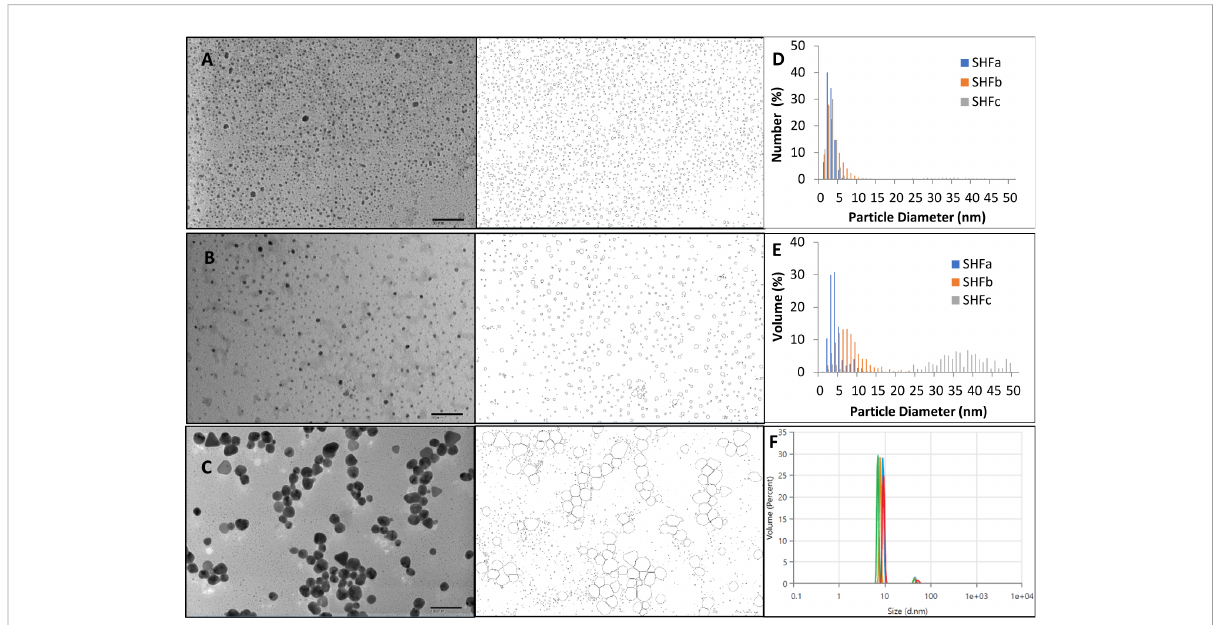
FIGURE 1 The representative TEM images and particle outlines of (A) SHFa, (B) SHFb and (C) SHFc. The nanoparticle size number distribution of the three products is shown in (D) and the volume distribution in (E) DLS particle volume distribution of SHFb is shown in (F)